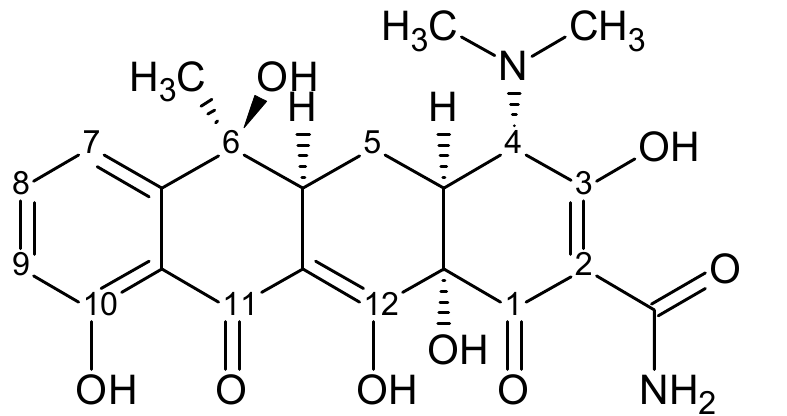
Figure 7. Chemical structure of tetracycline hydrochloride .